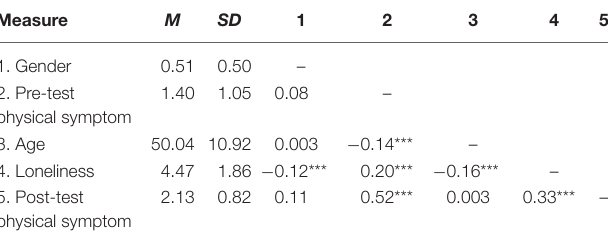
TABLE 4 | Descriptive statistics and correlations among measures in Study 2. Measure